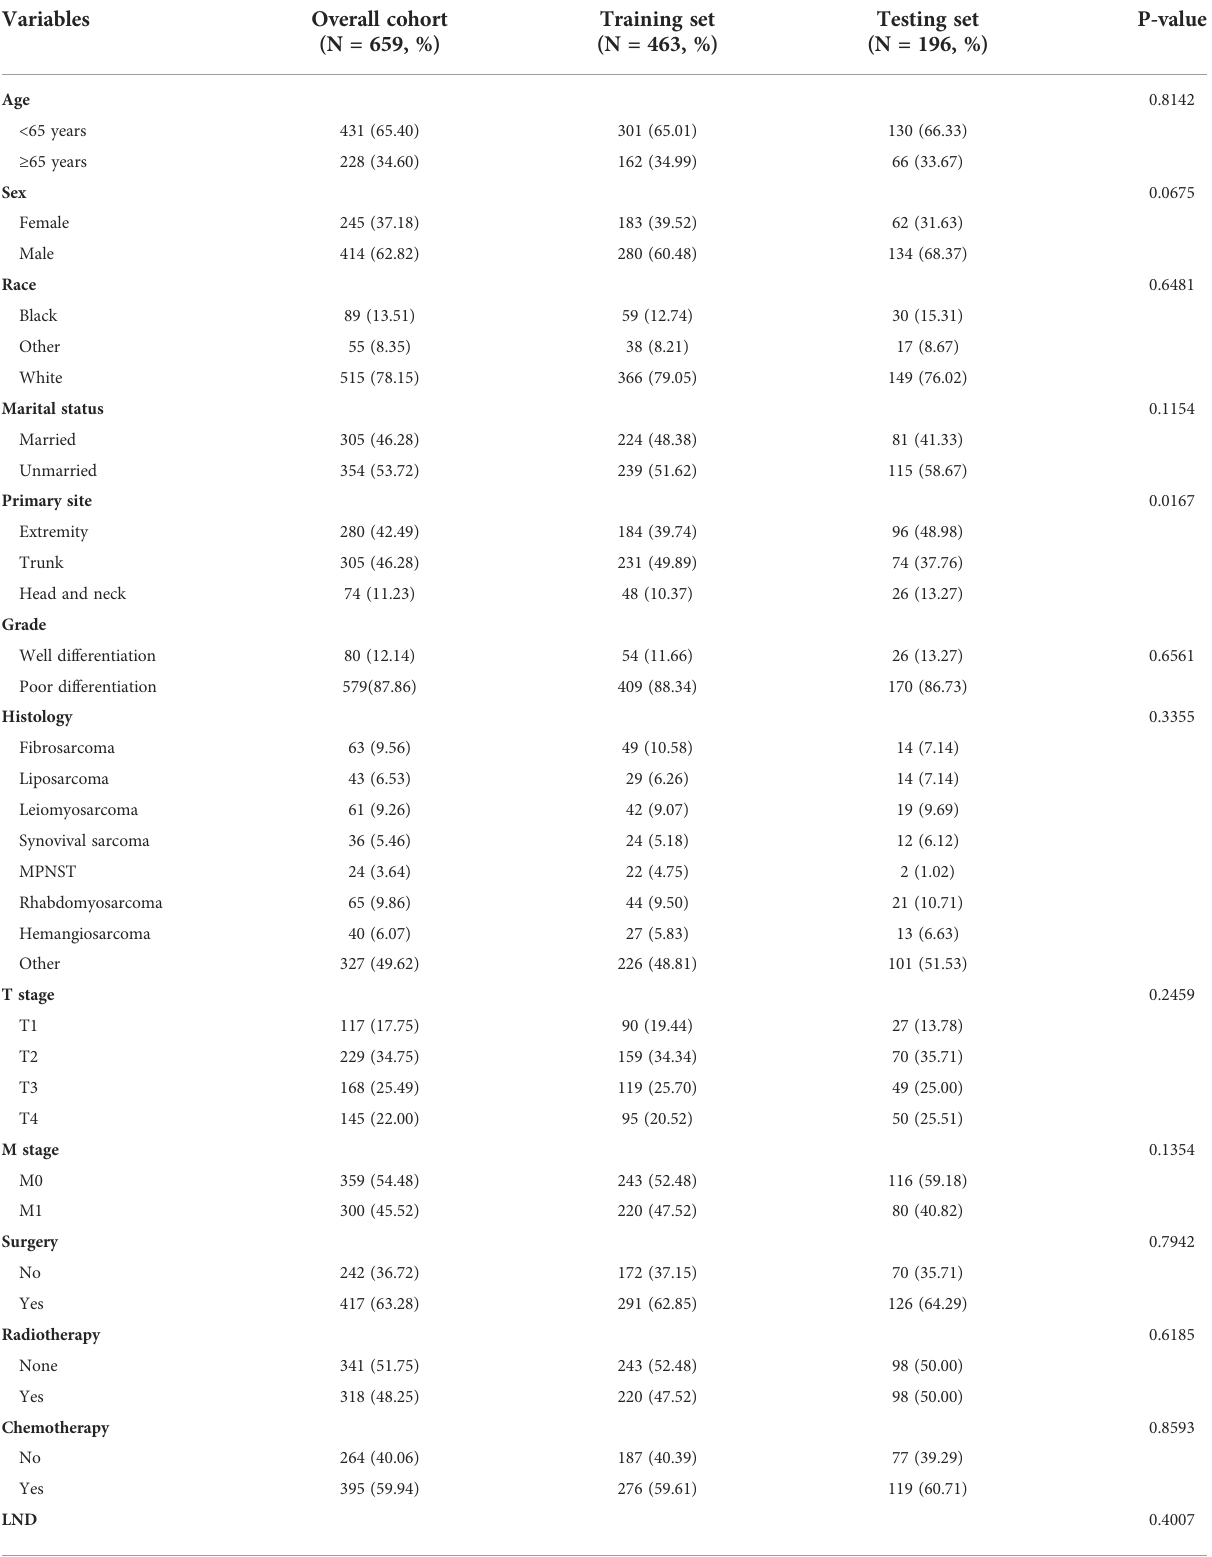
TABLE 4 The baseline characteristics of patients with soft tissue sarcoma with lymph node